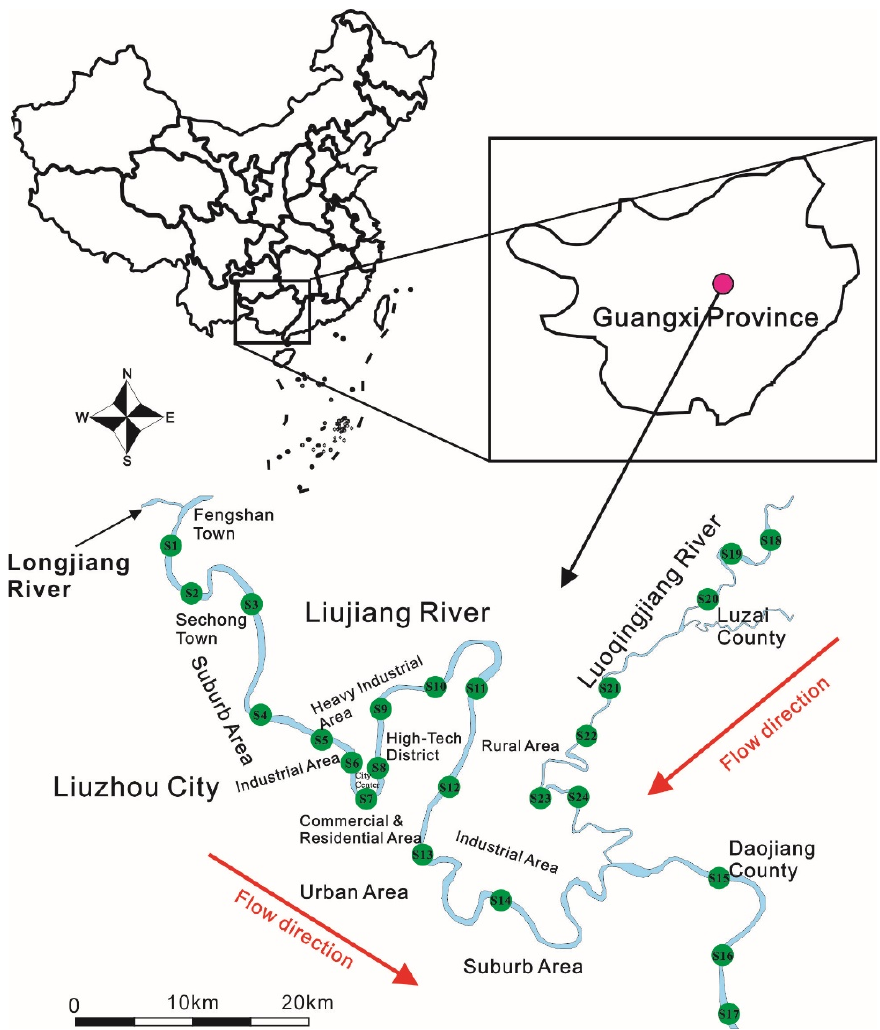
Figure 1. Sample plots in Liujiang River Basin [2].